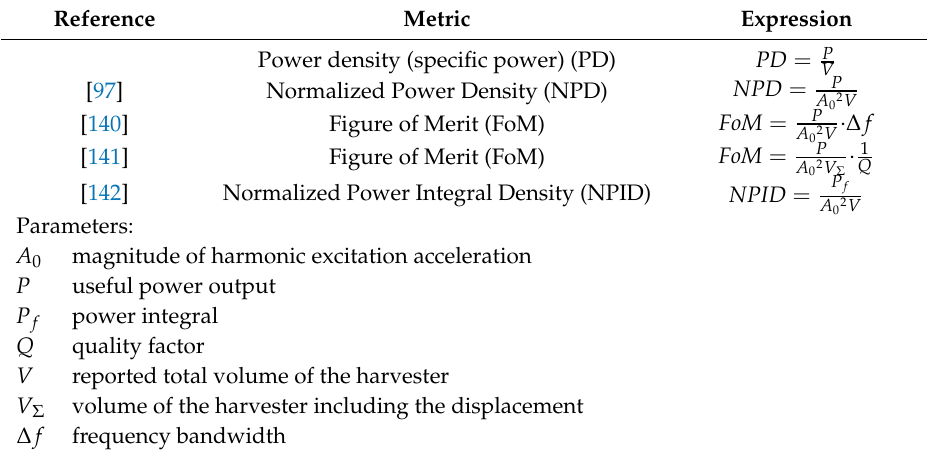
Table 1. Summary of used metrics for EH